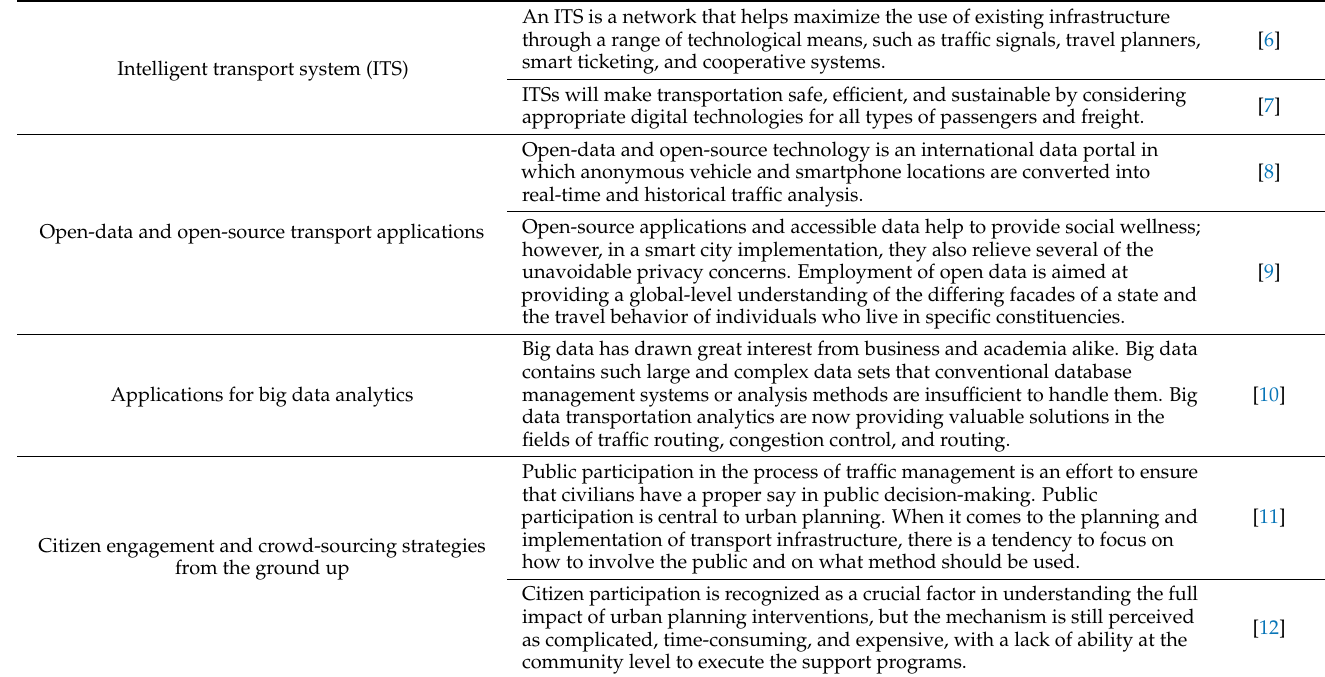
Table 2. Definitions of markers for smart mobility in the